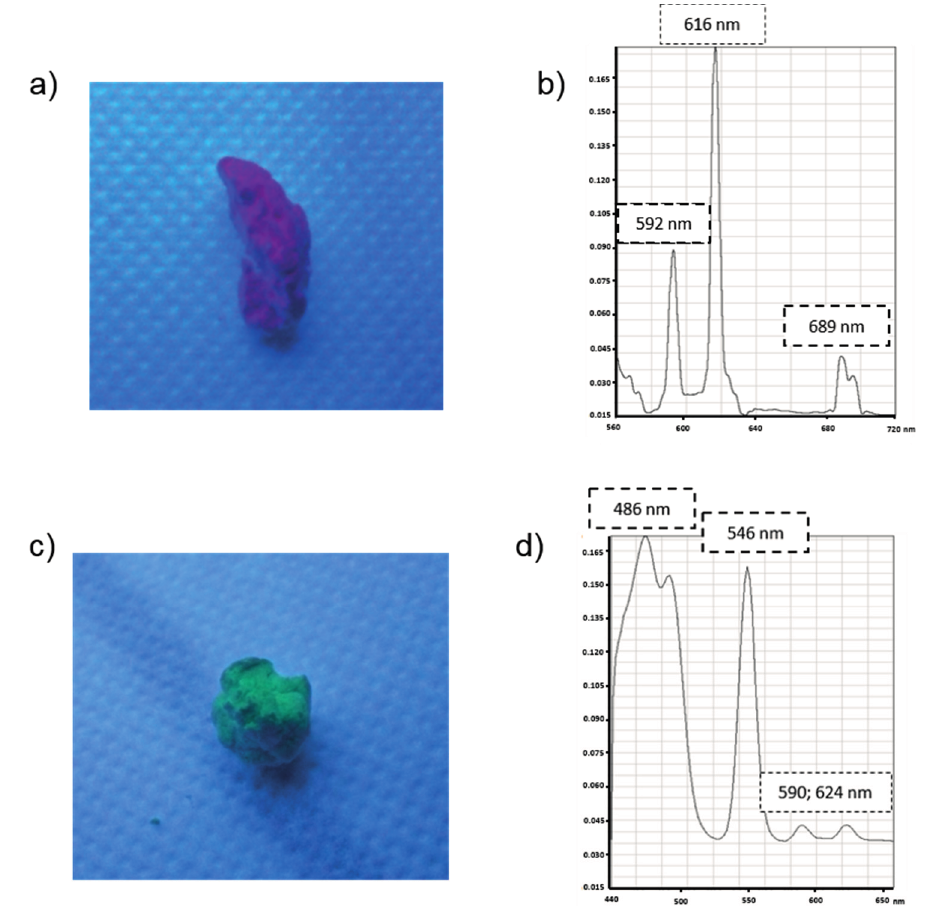
Figure 6. ( a ) The image of sample material obtained from run 12 as seen under the UV lamp and ( b ) the luminescence spectrum of the same sample showing the characteristic peaks of Eu 3+ ; ( c ) the image of sample material obtained from run 15 as seen under the UV lamp and ( d ) the luminescence spectrum of the same sample showing the characteristic peaks of Tb 3+